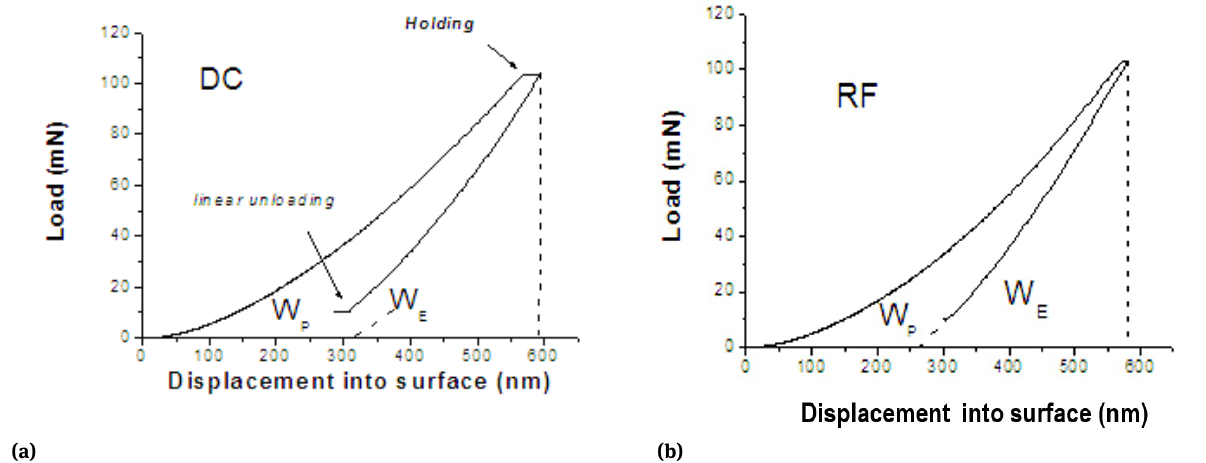
Figure 10: The nanoindentation load depth curves for (a) DC and (b) RF modes Si-C-N coatings on silicon substrates [170]